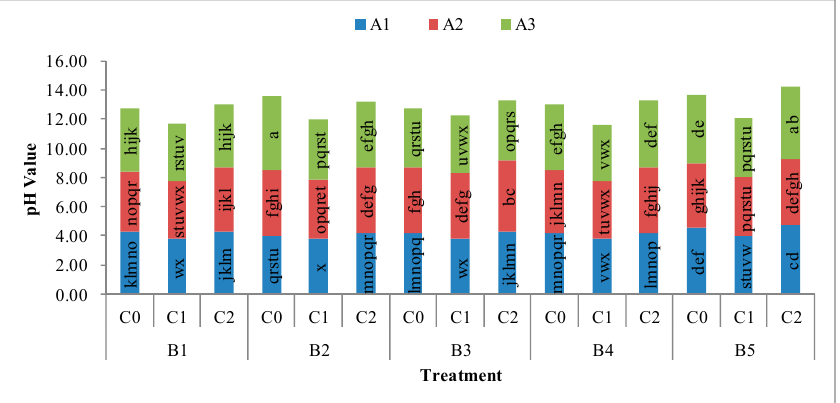
Figure 5. Differences in pH value for the interactions of forage species, cutting stage and additive. A1: triticale; A2: rye; A3: oat; B1: heading stage; B2: flowering stage; B3: grouting stage; B4: milky stage; B5: dough stage; C0: additive-free treatment; C1: Sila-Max; C2: Sila-Mix. a b c d e et al. indicated the significant difference level between treatments ( p < 0.05). If all marked letters between the two treatments had a same letter, the difference between the two treatments was not significant, and if the marked letters were all different between the two treatments, the difference was significant.